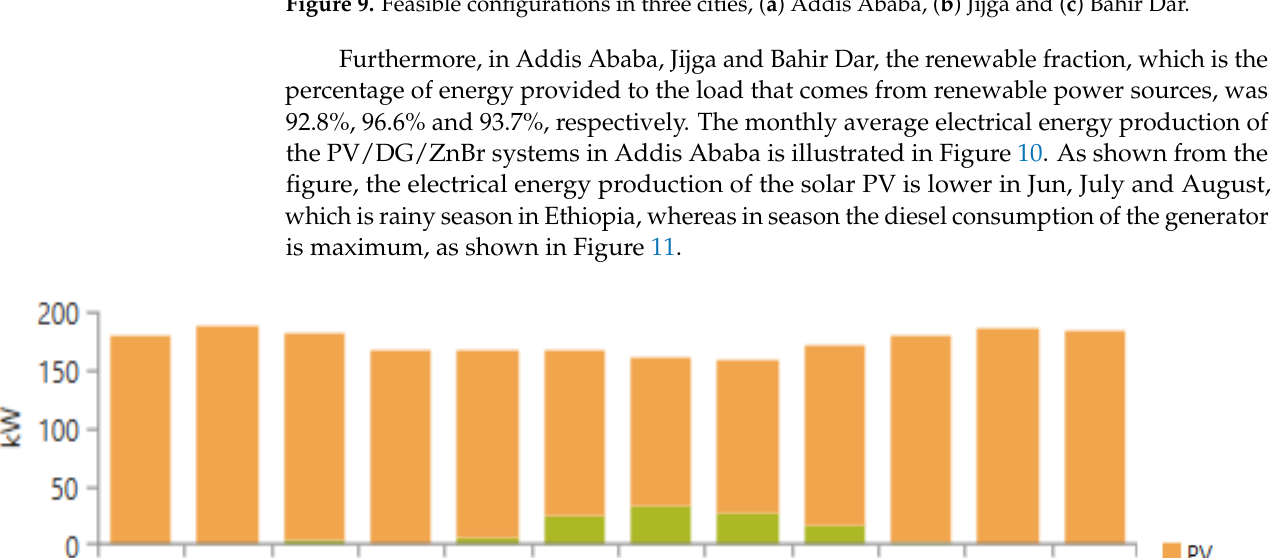
Figure 10. Monthly Average Electric Production.